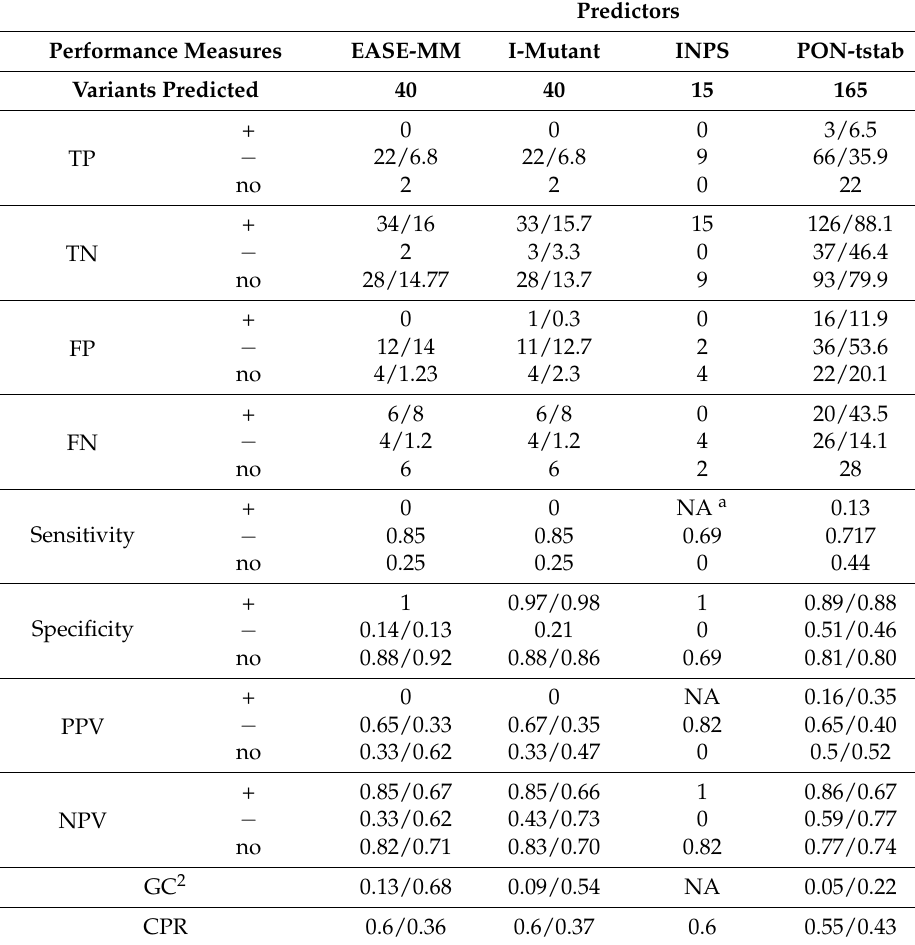
Table 3. Performance of PON-tstab and comparison to other